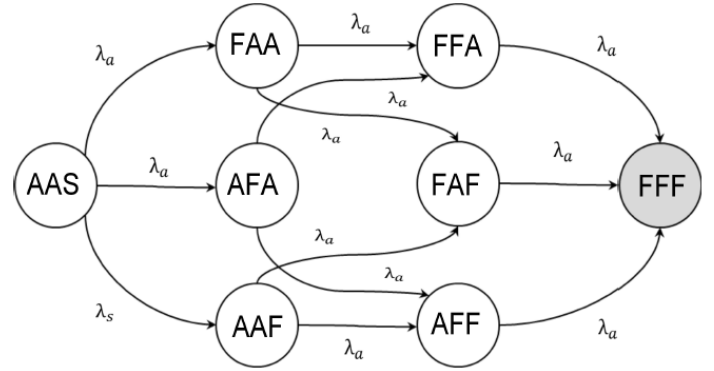
Fig. 3. CTMC for PM subsystem without CCF